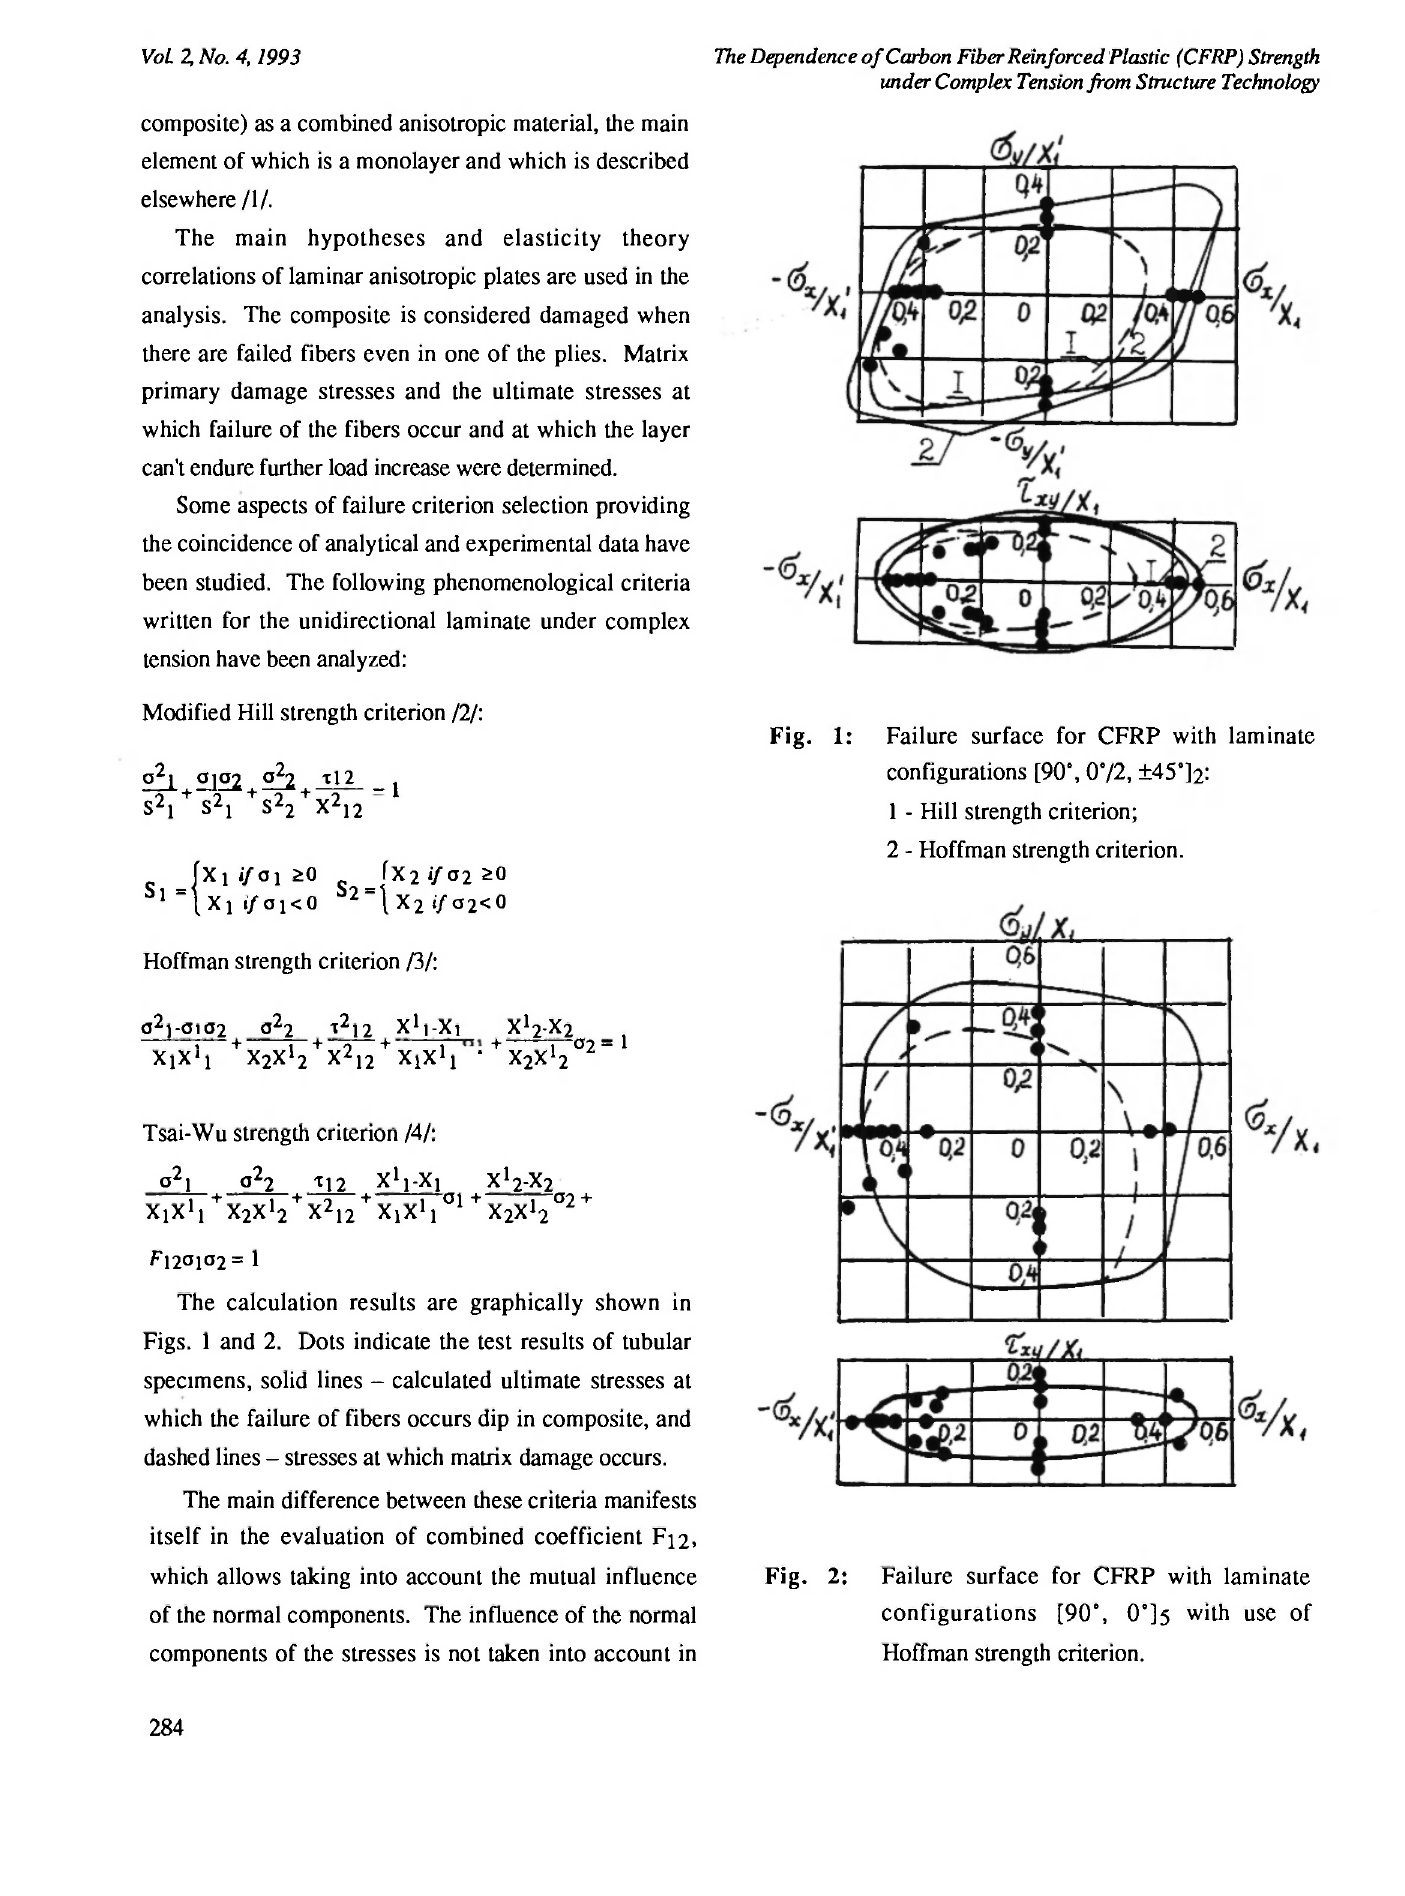
Fig. 2: Failure surface for CFRP with laminate configurations [90°, 0°]5 with use of Hoffman strength